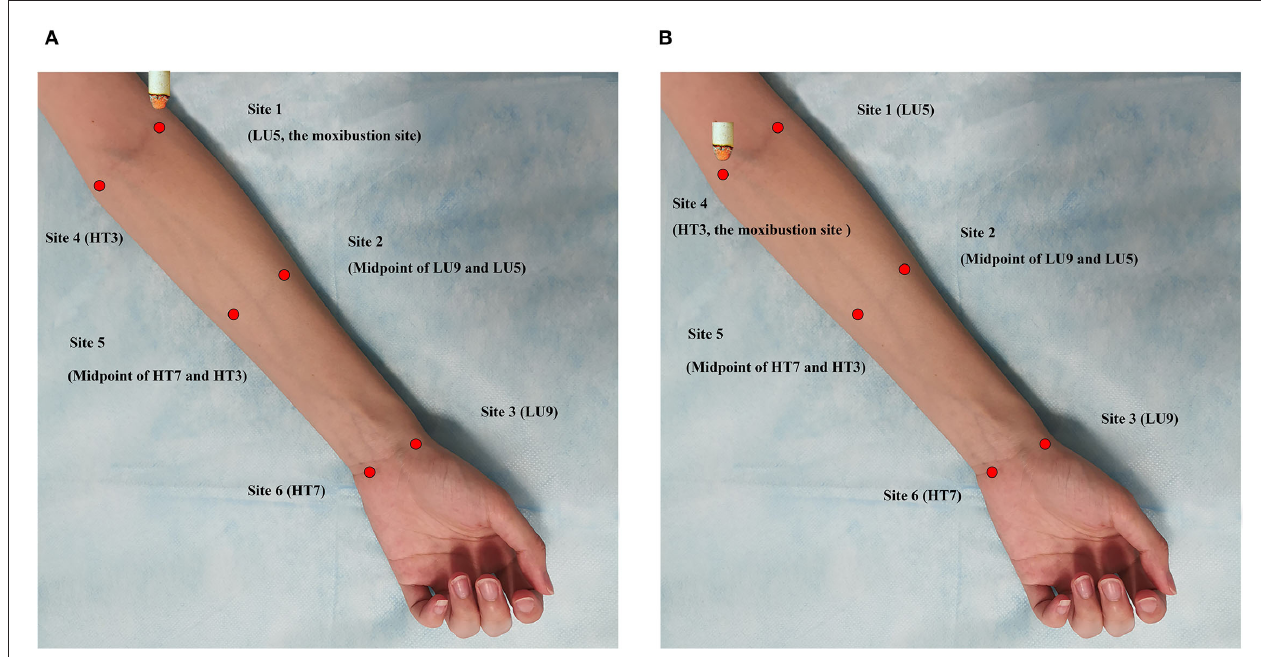
FIGURE 2 | The schematic of the experiment and the positions of monitoring points. (A) The Lung meridian intervention group. Moxibusition site: Site 1 (LU5); IRT monitoring sites: Site 1 (LU5), Site 2 (Midpoint of LU9 and LU5), Site 3 (LU9), Site 4 (HT3), Site 5 (Midpoint of HT7 and HT3), Site 6 (HT7). (B) The Heart meridian intervention group. Moxibusition site: Site 4 (HT3); IRT monitoring sites: Site 1 (LU5), Site 2 (Midpoint of LU9 and LU5), Site 3 (LU9), Site 4 (HT3), Site 5 (Midpoint of HT7 and HT3), Site 6 (HT7).